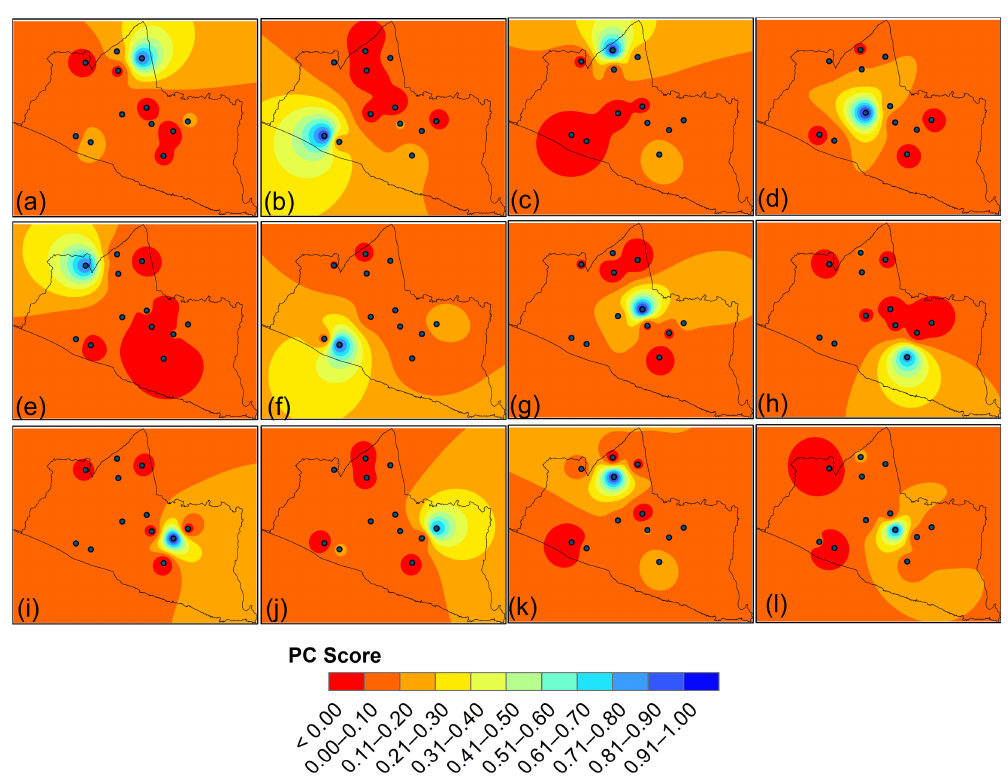
Figure 8. Spatial distribution of monthly rainfall that resulted from principal component analysis in inter-monsoon season with ( a ) PC1; ( b ) PC2; ( c ) PC3; ( d ) PC4; ( e ) PC5; ( f ) PC6; ( g ) PC7; ( h ) PC8; ( i ) PC9; ( j ) PC 10; ( k ) PC11; ( l ) PC12;